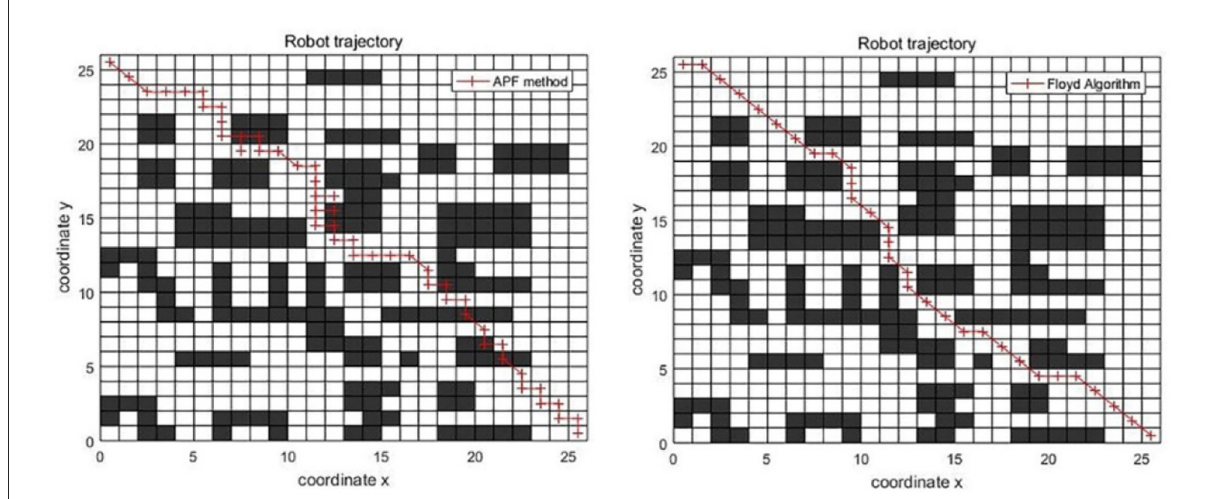
FIGURE3 Comparison of boot paths.